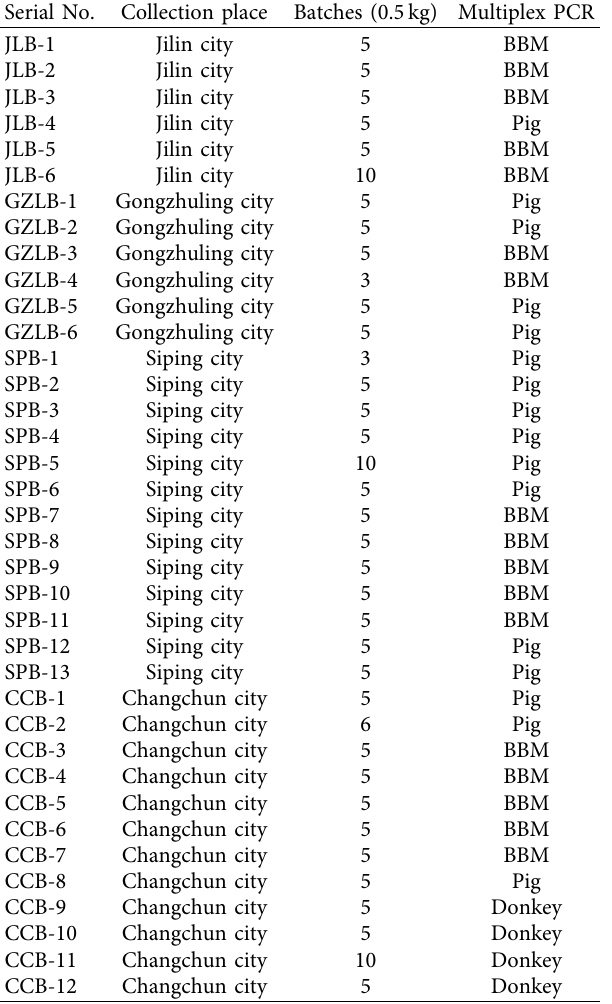
Table 2: Evaluation of commercially available samples collected from different cities in China using a multiplex